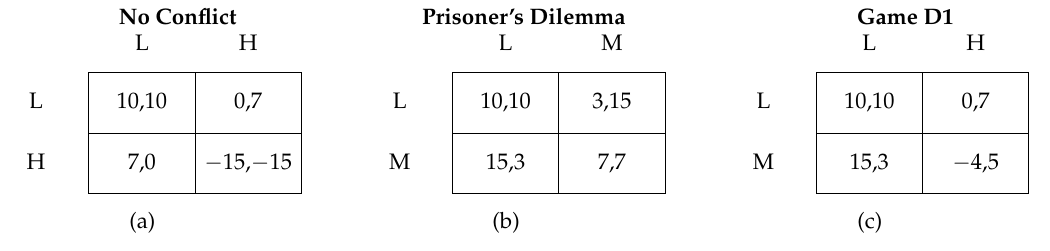
Figure 5. Subgames used in constructing the self-supporting sets in the duopoly